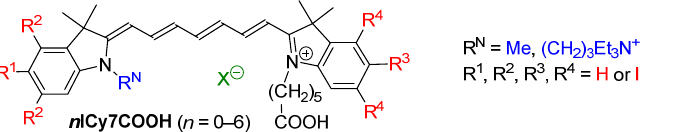
Figure 1. Heptamethine cyanine dyes n ICy7COOH , where n is the number of iodine atoms ( n = 0– 6), investigated in [32]. investigated in